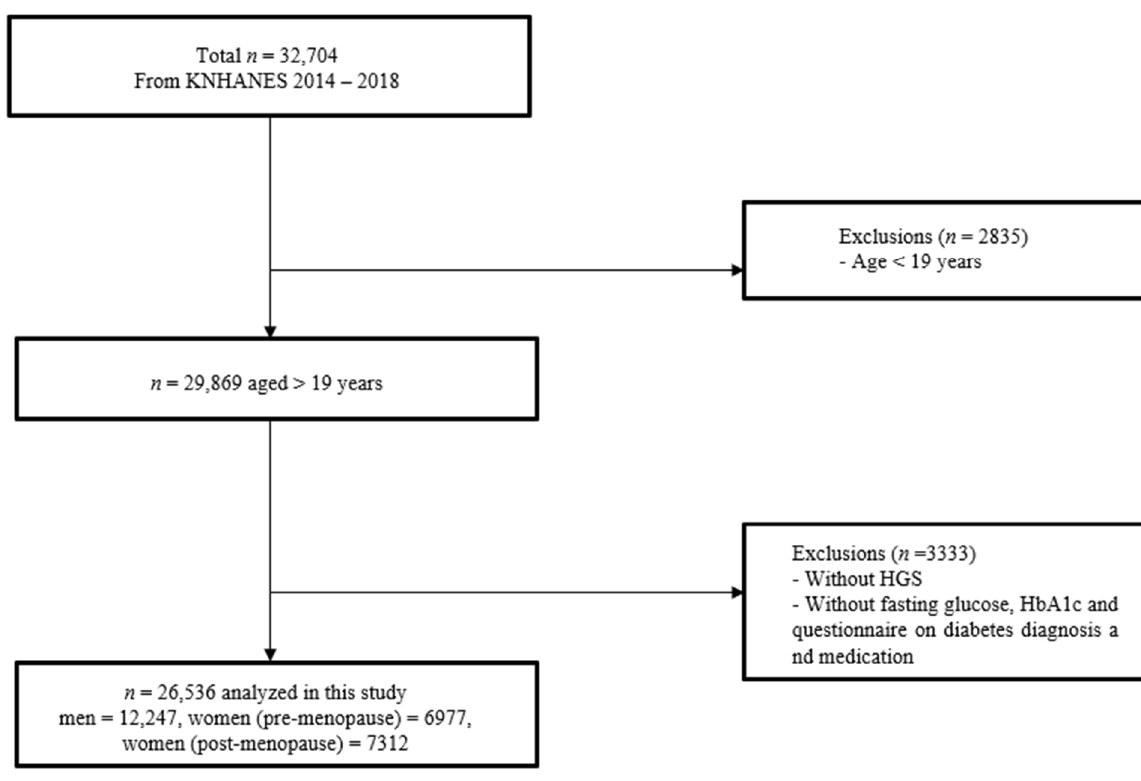
Figure 1. Flow diagram of subjects meeting the inclusion/exclusion criteria. The use of KNHANES (2014–2018) data was approved by the Institutional Review Board (IRB) of the Korea Centres for Disease Control and Prevention (IRB No. 2013-12EXP- 03-5C, 2015-01-02-6C, and 2018-01-03-P-A). This study was conducted in accordance with the Declaration of Helsinki. Informed consent was obtained from all the participants. The original data are publicly available for free on the KNHANES website (http://knhanes.cdc. go.kr, accessed on 27 July 2022) for academic